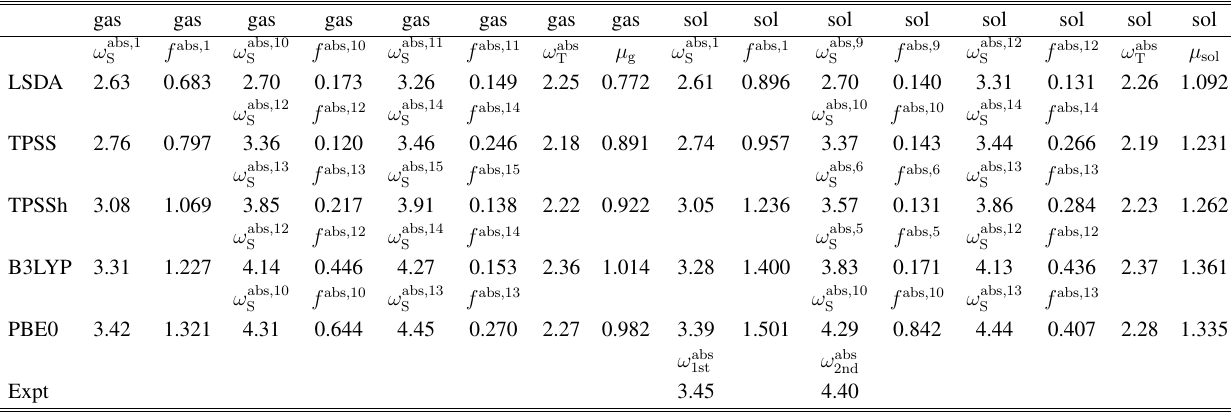
The same as Table 11, but for BDBPQ. Experimental values measured in chloroform are obtained from Ref. [1].